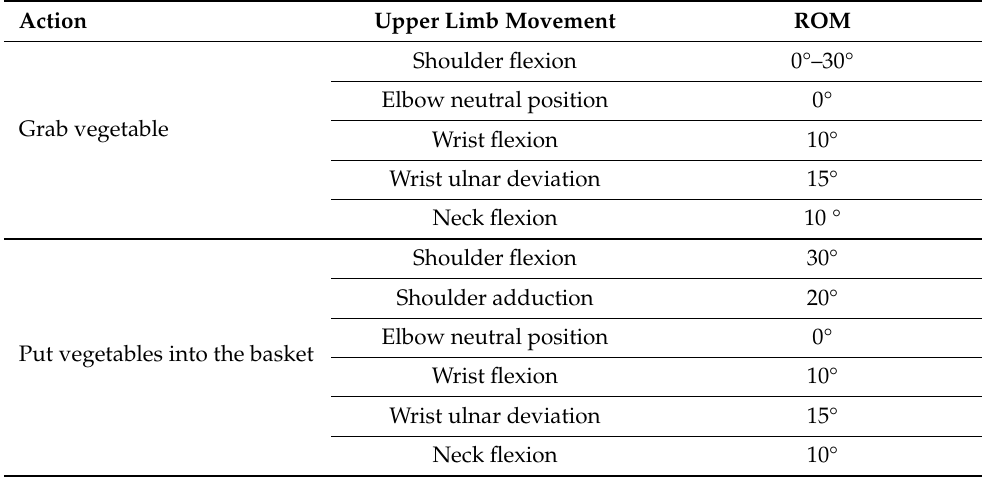
Table 6. Sequence of actions and the upper limb movements involved in the picking vegetables up off the ground